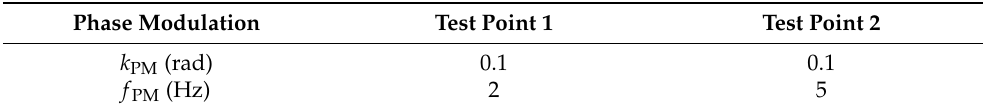
Table 9. Proposed test point for phase modulation. Phase Modulation